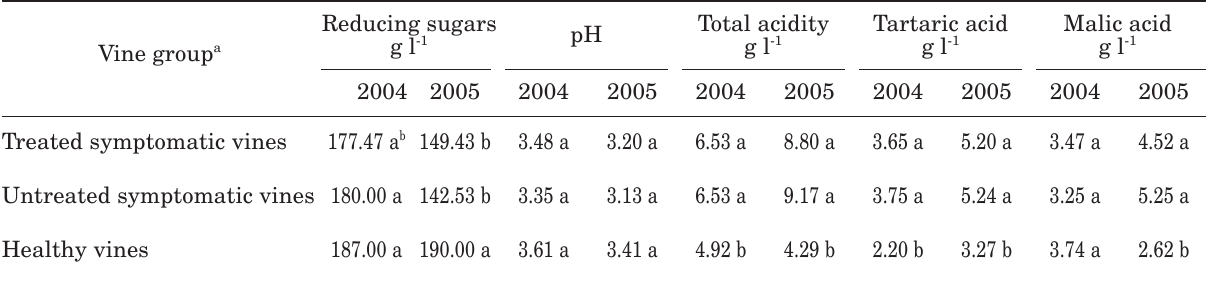
Values are expressed as c 2 and do not express statistically differences over Table 7. Chemical analysis carried out in the Controguerra vineyard on musts from berries without lesions of treat- ed and untreated symptomatic vines affected with esca proper and from berries of healthy vines.